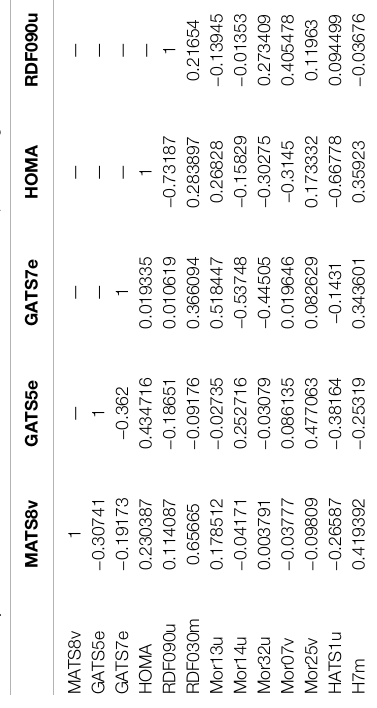
reliability of the